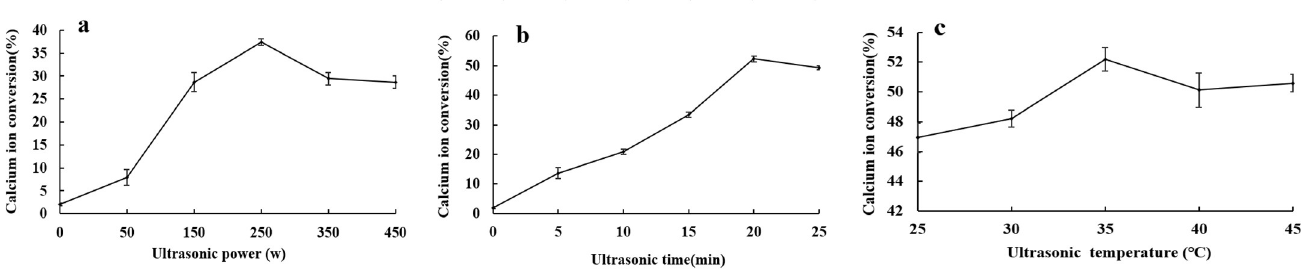
Fig 1. Effect of ultrasonic power, ultrasonic time and ultrasonic temperature on the free calcium extraction rate from bovine bone.